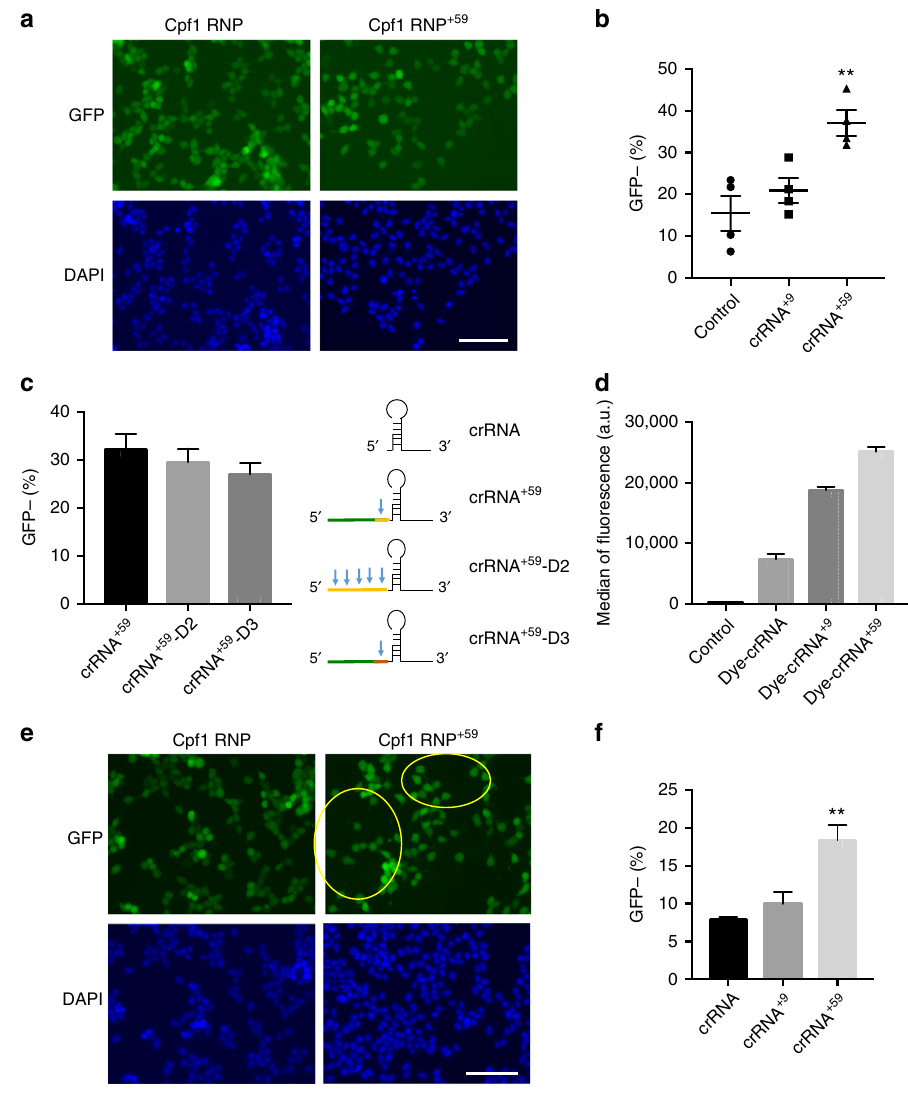
Fig. 6 crRNA + 59 enhances the delivery ef fi ciency of Cpf1 RNP with Lipofectamine or cationic polymers in GFP-HEK cells. a Fluorescence image of GFP-HEK cells after Cpf1 RNP transfection with Lipofectamine. Hoechst stains nucleus. Scale bar is 100 μ m. b Quanti fi cation of GFP knockout cell population after Cpf1 RNP delivery with Lipofectamine. crRNA + 59 complexed with Cpf1 (Cpf1 RNP + 59 ), 100 nucleotide in length, is more ef fi cient at inducing indel mutations in cells after Lipofectamine transfection than wild-type crRNA complexed with Cpf1 (41 nt in length). Mean ± SE, n = 3. ** p < 0.01 by Student ’ s t test compared to crRNA control. c Schematic diagram of crRNA + 59 sequences with three different sequence extensions. Quanti fi cation of GFP knockout cell population after Cpf1 RNP delivery with Lipofectamine. Mean± SE, n = 3. d Cellular delivery of Cpf1 RNP using Lipofectamine is dependent on crRNA length. crRNAs with different length were labeled with a fl uorescent dye and Cpf1 RNPs were delivered with Lipofectamine in HEK 293T cells. The median fl uorescence intensity in each cell was higher with crRNA extension. Mean± SE, n = 3. e Fluorescence image of GFP-HEK cells after Cpf1 RNP transfection with PAsp(DET). The areas that cells lost GFP are marked with yellow circles. Hoechst stains nucleus. Scale bar is 100 μ m. f Quanti fi cation of GFP knockout cell population. Cpf1 RNP + 59 , 100 nucleotides in length, is more ef fi cient at inducing NHEJ in cells after PAsp(DET) polymer nanoparticle transfection than wild-type crRNA (41 nt in length). Mean± SE, n = 3. ** p < 0.01 by Student ’ s t test compared to crRNA